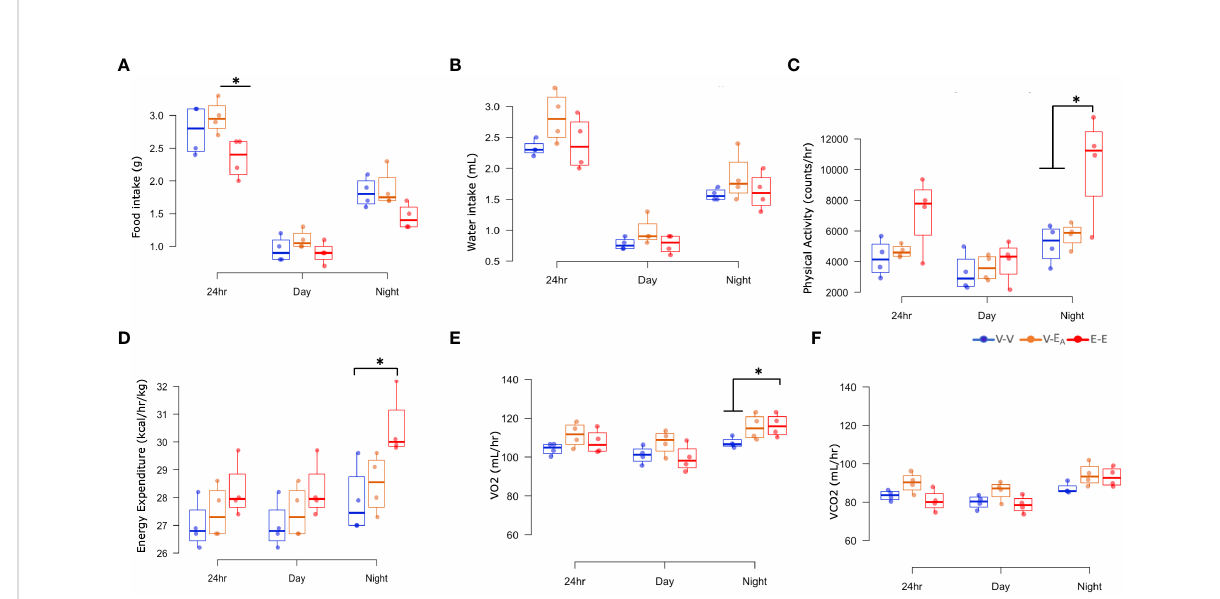
FIGURE 4 Estradiol, but not fecal microbiota transplant (FMT) from E2-treated mice supplemented with A . muciniphila , protected against changes in energy intake and expenditure in HFD-fed female mice. (A) Food intake, (B) Water intake, (C) Physical activity, (D) Energy expenditure, (E) VO2 consumption, and (F) VCO2 production were measured in metabolic cages on D18 – 21 (A – D) : *p < 0.05, ANOVA, Tukey post-hoc ; (E) : *p < 0.05, ANCOVA, Tukey post-hoc ). E-E, E2-treated mice receiving FMT from E2 mice (n = 4); V-V, mice with Veh implants receiving FMT from Veh mice (n = 4); V-E A , mice with Veh implants receiving FMT from E2-treated mice supplemented with A . muciniphila (n =